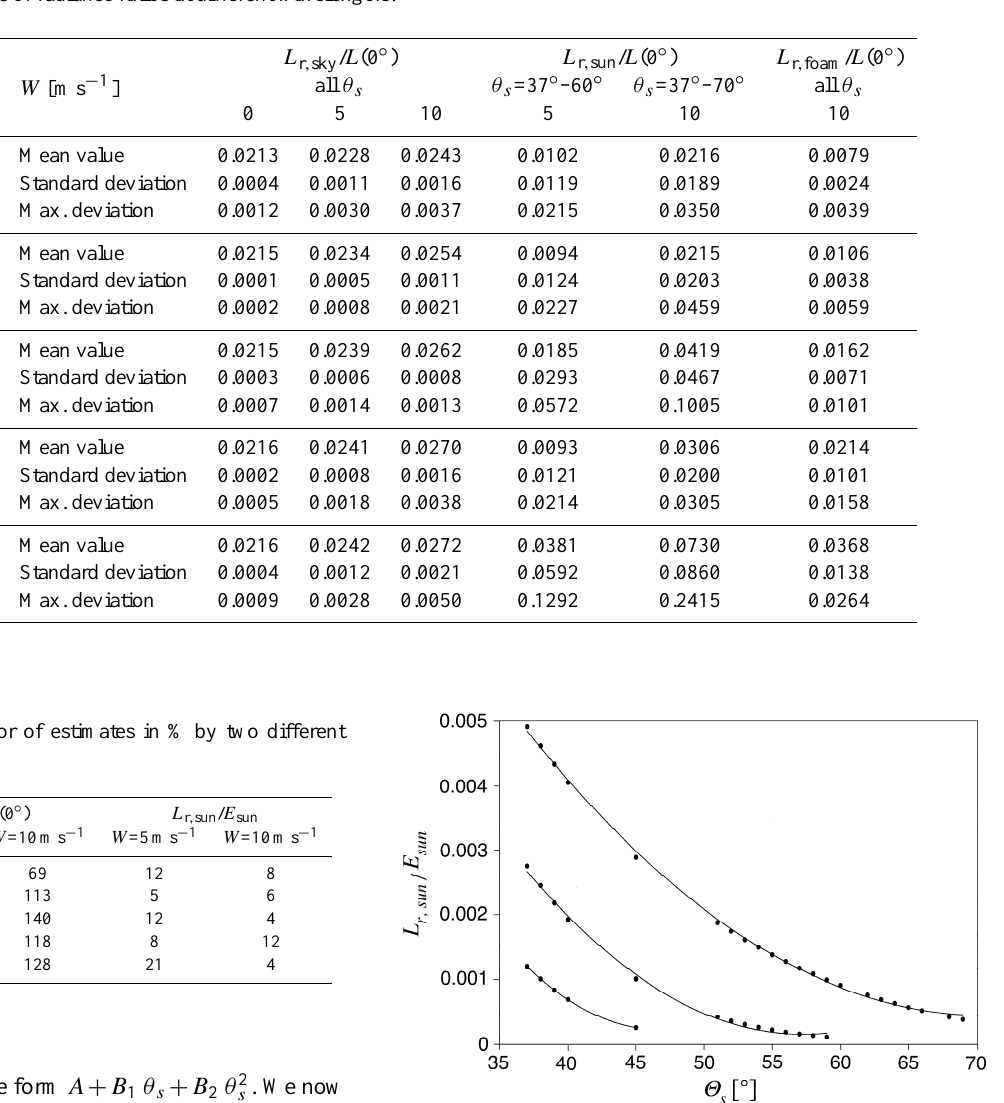
Table 3. Statistical properties of radiance ratios at different wavelengths.